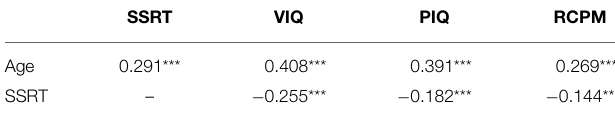
TABLE 3 | Correlations between age, SSRT and intelligence